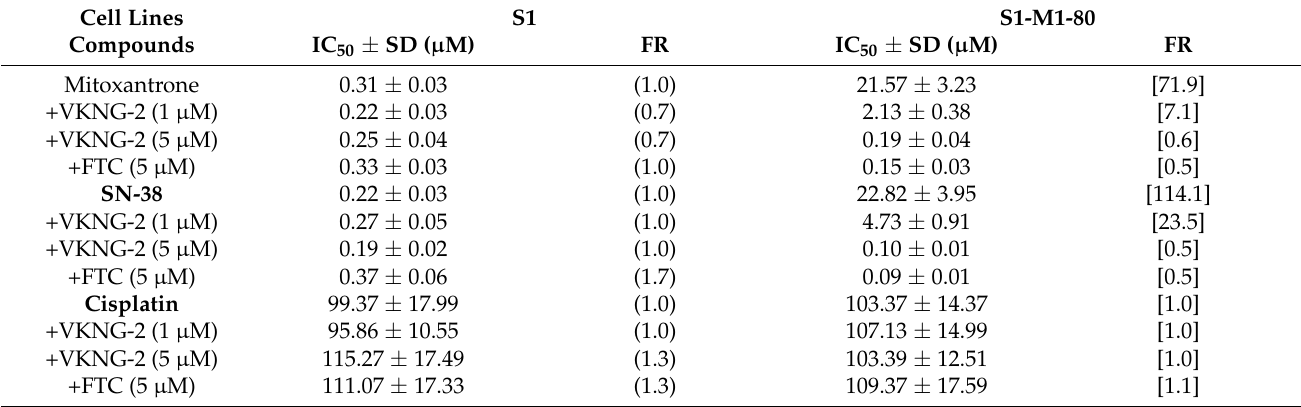
Table 2. The effect of VKNG-2 on reversal of ABCG2 mediated MDR in the drug selective cell lines.